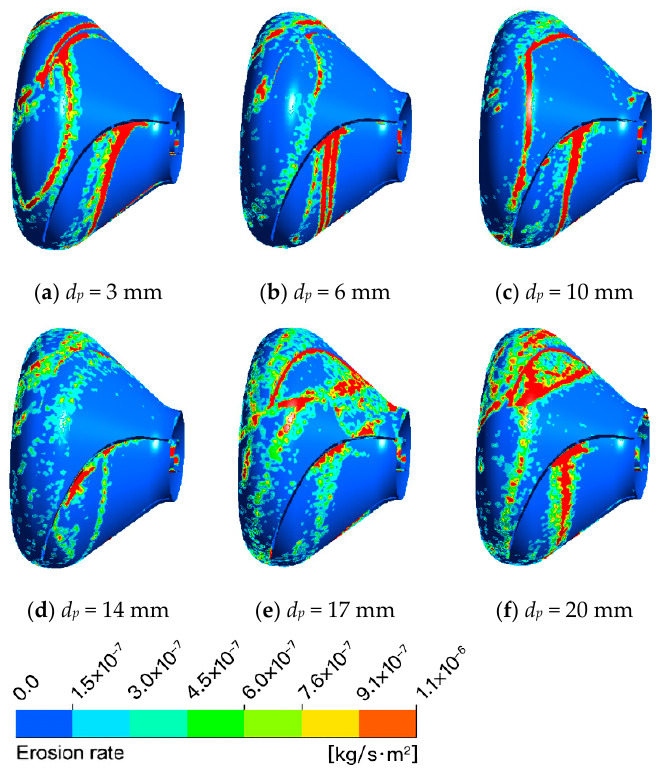
Figure 9. Wear distribution on the surface of the guide vanes.